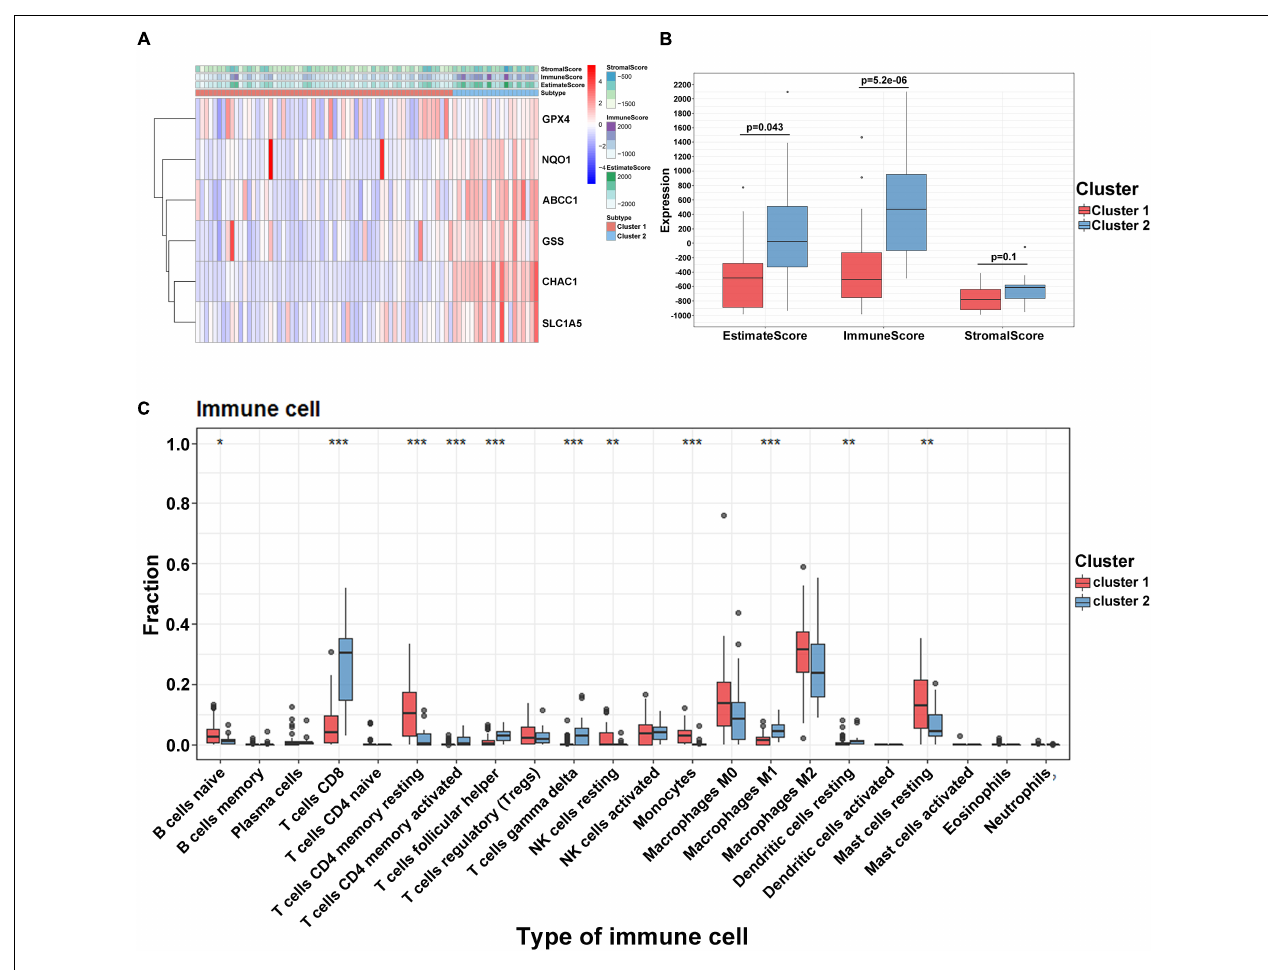
FIGURE 4 | Tumor immune microenvironment in module A. (A) The heatmap of ferroptosis-related regulators in two clusters. (B) The different expression of ESTIMATE score in two clusters. (C) The different distribution of 22 TME infiltrating cells in two patterns (*** p < 0.001; ** p < 0.01; * p <